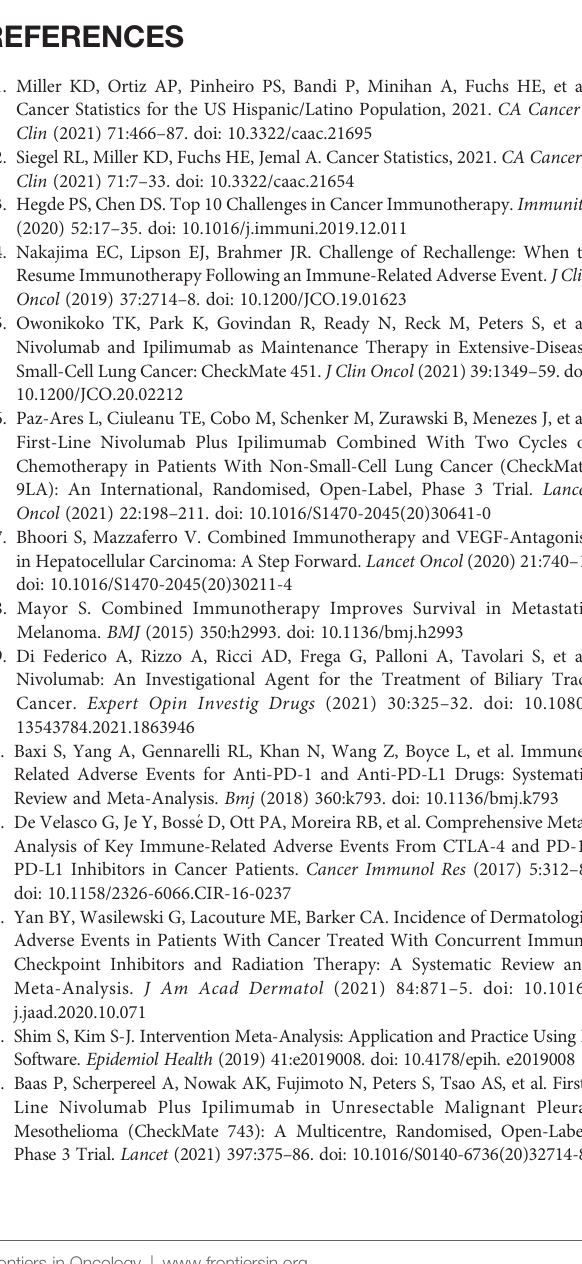
Supplementary Figure 6 | Forest plot of adverse events leading to discontinuation in N1-I3 subgroup. Supplementary Figure 7 | Forest plot of treatment-related deaths in N3-I1 subgroup. Supplementary Figure 8 | Forest plot of adverse events leading to discontinuation in N3-I1 subgroup. Supplementary Figure 9 | Forest plot of any adverse events in different cancers. Supplementary Figure 10 | Forest plot of grade 3 and higher adverse events in different cancers. Supplementary Figure 11 | Forest plot of any adverse event leading to discontinuation in different cancers. Supplementary Figure 12 |